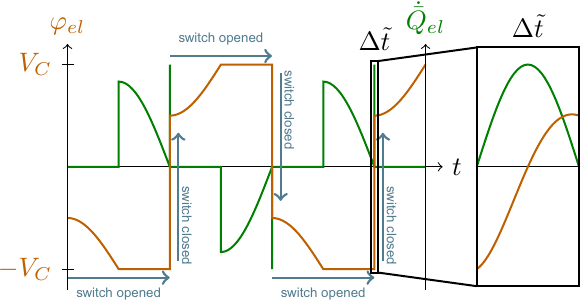
Fig. 2 Typical waveforms of 𝜑 el and ̇̄ Q el arising from the standard circuit under a harmonic base excitation of the electromechancial structure